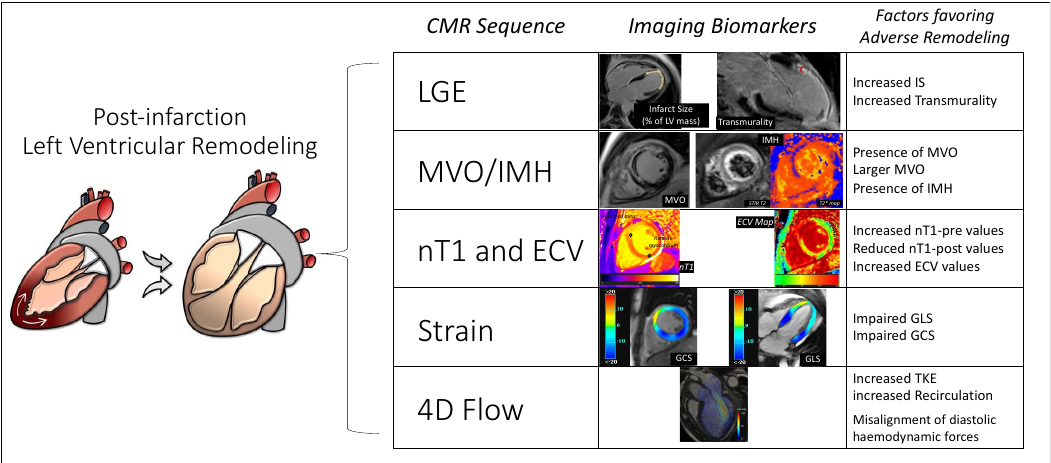
Figure 5. CMR imaging biomarkers in the risk prediction of adverse remodeling